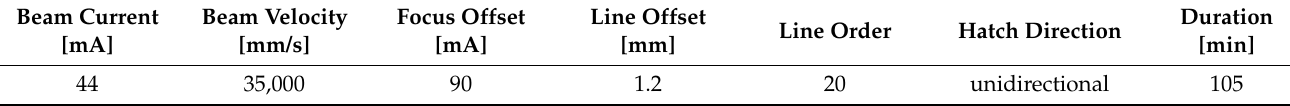
Table 2. Arcam Q20+ preheating